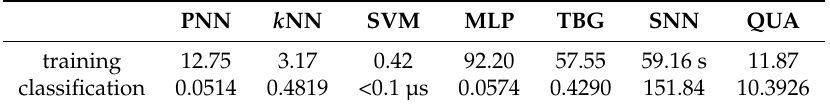
Table 4. Algorithm performance for person identification, time in milliseconds. The training time was measured for classes size of 1. The classification time was measured for one sample.